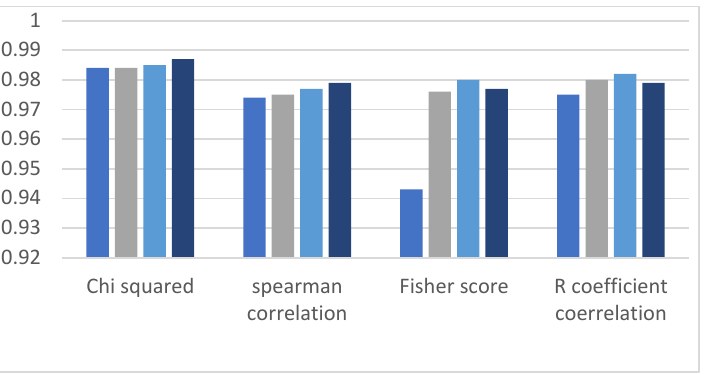
Figure 6. Accuracy using enhanced LR.